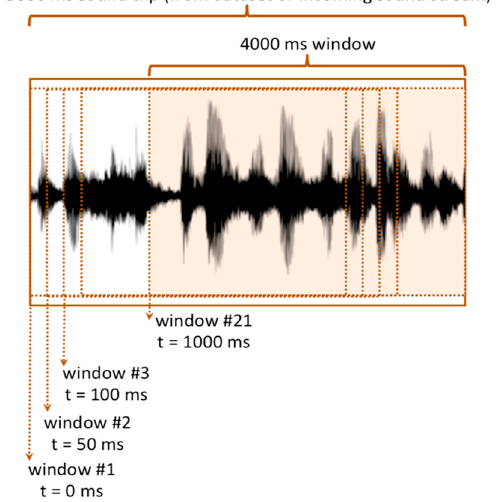
Figure 4. Sound acquisition and temporal sliding